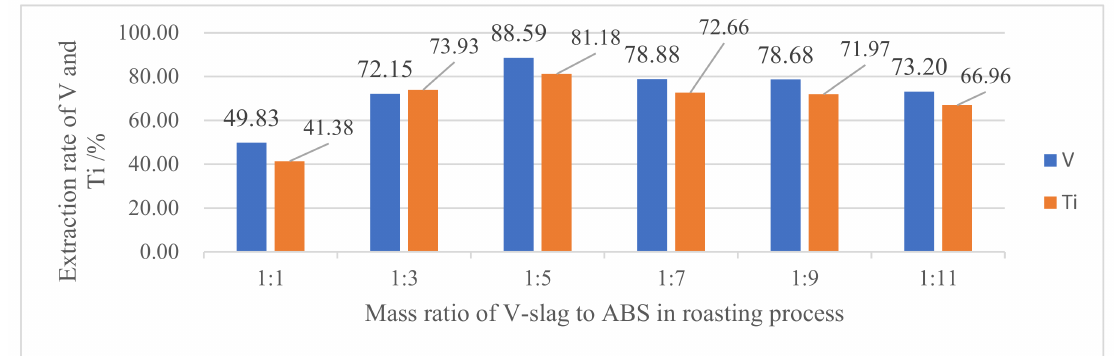
Figure 7. Effect of the ABS amount on the extractions of V and Ti.